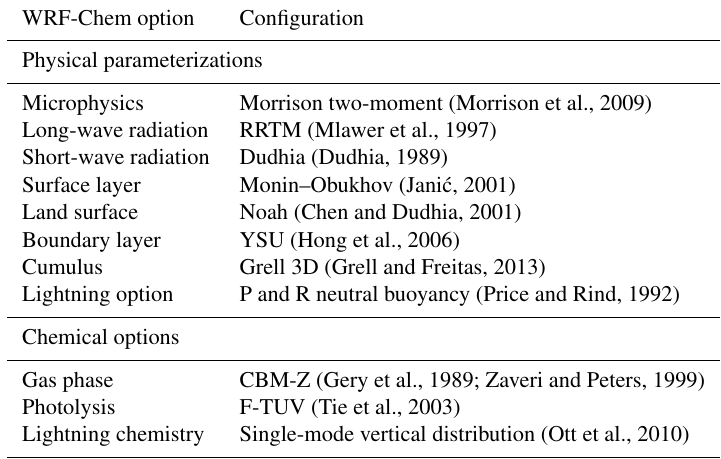
Table 1. WRF-Chem physical and chemical parametrization schemes. WRF-Chem